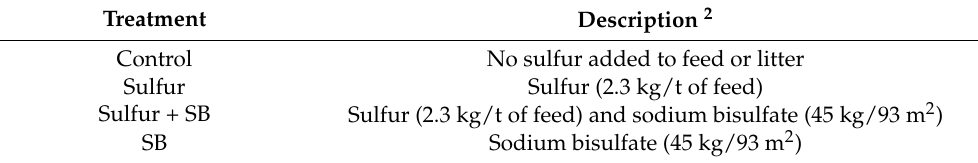
Table 1. Description of treatments 1